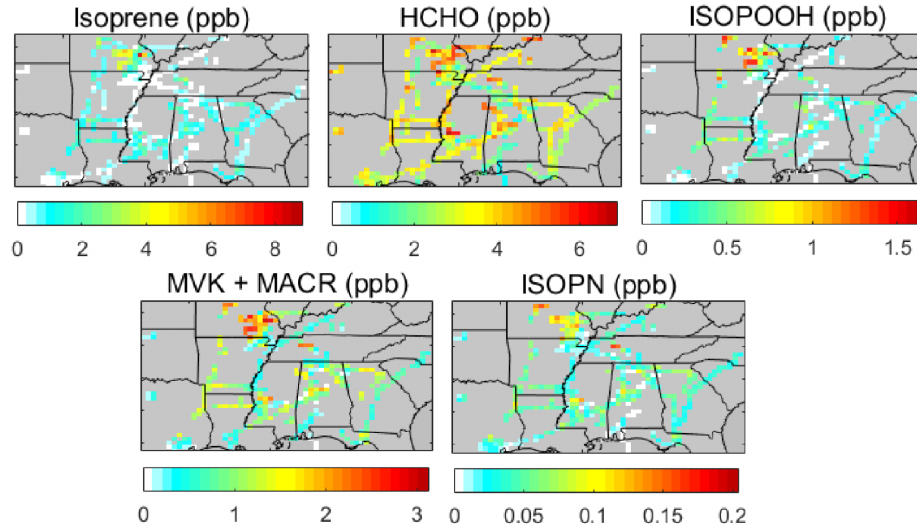
Figure 5. Mean boundary layer concentrations of isoprene and its oxidation products measured in the SEAC 4 RS aircraft campaign (1 August – 25 September 2013). The observations are for daytime (09:00 – 18:00LT) below 1.5km altitude, and exclude urban and fire plumes as described in the